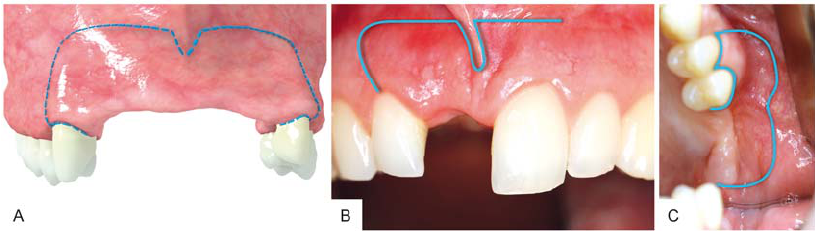
Figure 3. Remote incision techniques for augmentation procedures using a customized allogenic bone block. ( A ) Pillar incision performed as reported in this case. The horizontal part of the incision is positioned far up in the flexible mucosa in the vestibular fold and relief incisions are positioned in the posterior third of the adjacent teeth; ( B ) Semi pillar incision in case of a single tooth gap in the maxilla; ( C ) Lateral incision in case of a free end situation in the posterior maxilla. The cortical layer of the recipient site was perforated using a diamond bur to promote bleeding.